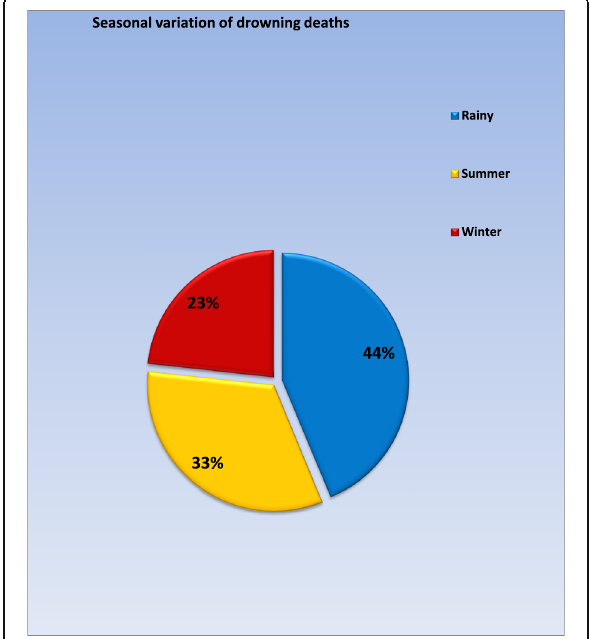
Fig. 5 Seasonal variation of drowning deaths